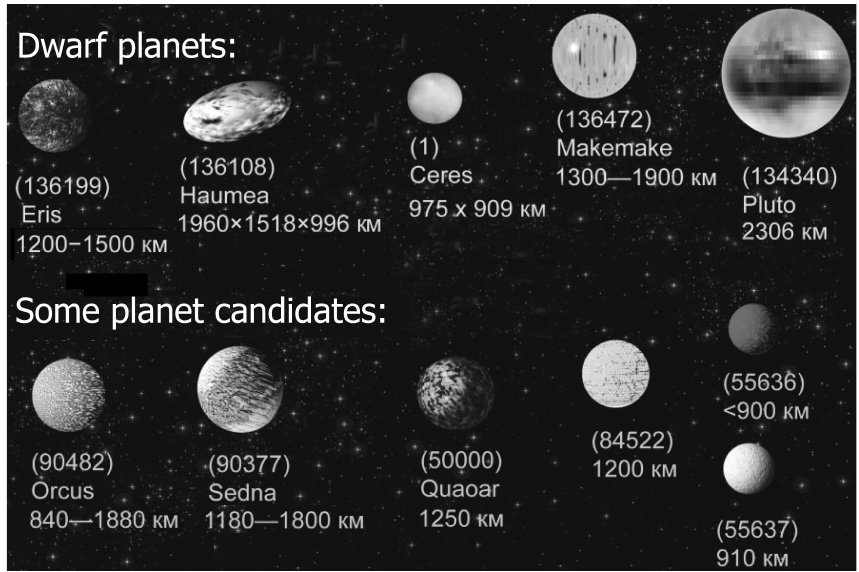
Fig. 1. Dwarf planets (Shustov & Rykhlova 2010).